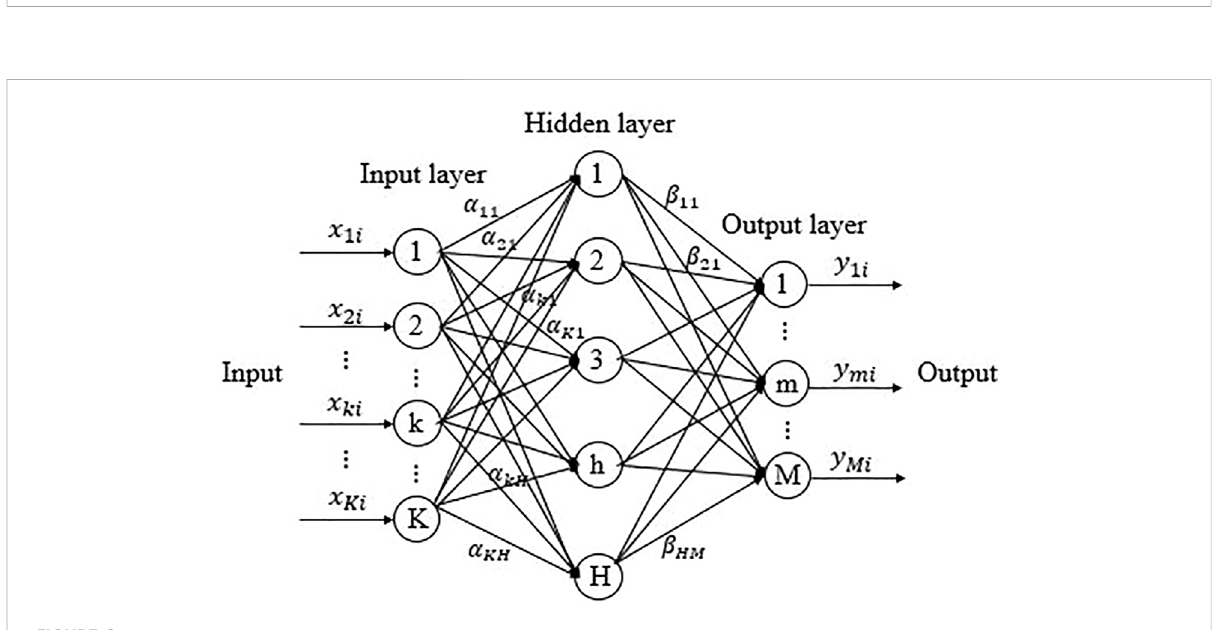
FIGURE 6 Multilayer feedforward neural network